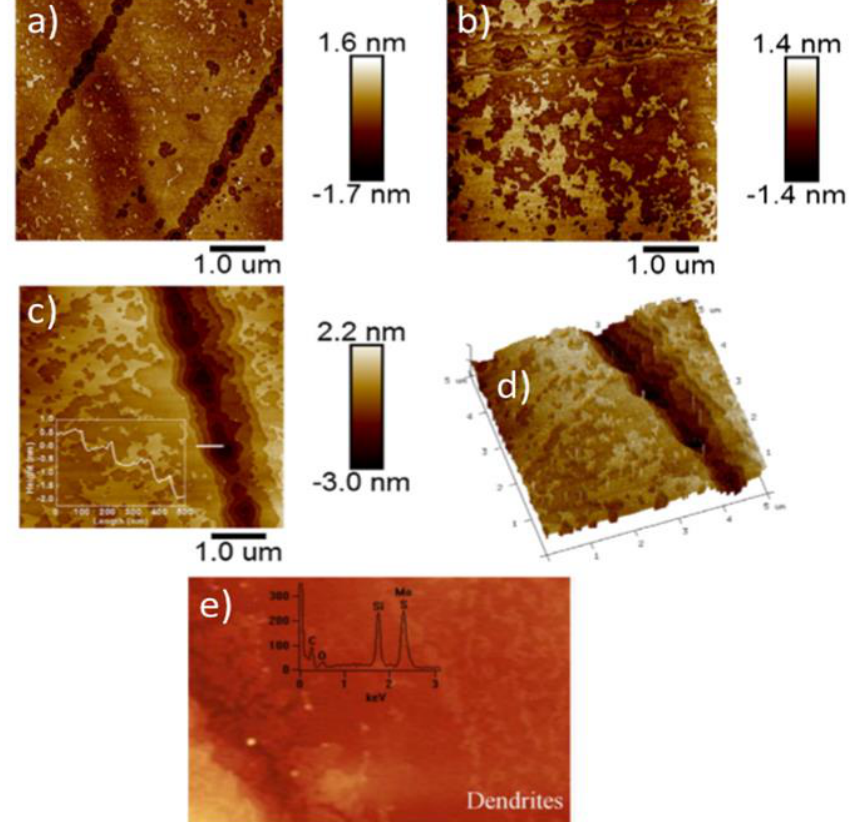
Figure 12. AFM topographical characterization of vigorous oxidation of single MoS 2 flakes above 500 ◦ C. (Color online) ( a , b ) 500 ◦ C in air for 10 min and 1 h, respectively; ( c , d ) 500 ◦ C in air for 2 h; ( e ) after several heating rounds of 5–10 min each in temperatures 270–470 ◦ C, followed by a last round at 500 ◦ C. Lateral image dimension of 5 µ m. Inset: EDS spectrum after a final round of heating. Visible dendritic structures are present on the MoS 2 surface. See their discussion in text. Parts ( a – d ) are reprinted from Reference [45], Copyright (2017), with permission from Elsevier. Part ( e ) was reprinted from Reference [41], with permission. Copyright 2017 American Chemical Society.